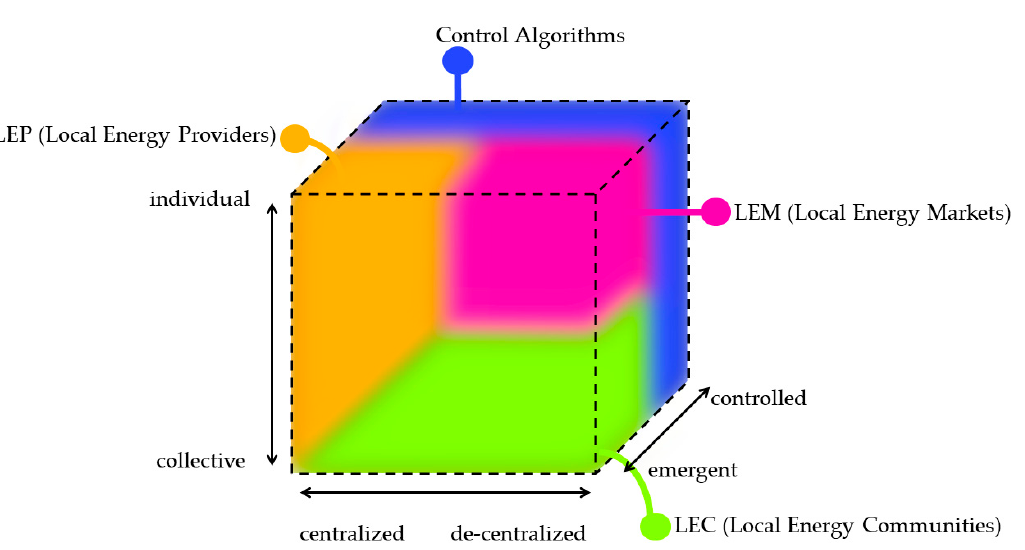
Figure 3. District scale renewable energy systems behaviour map.